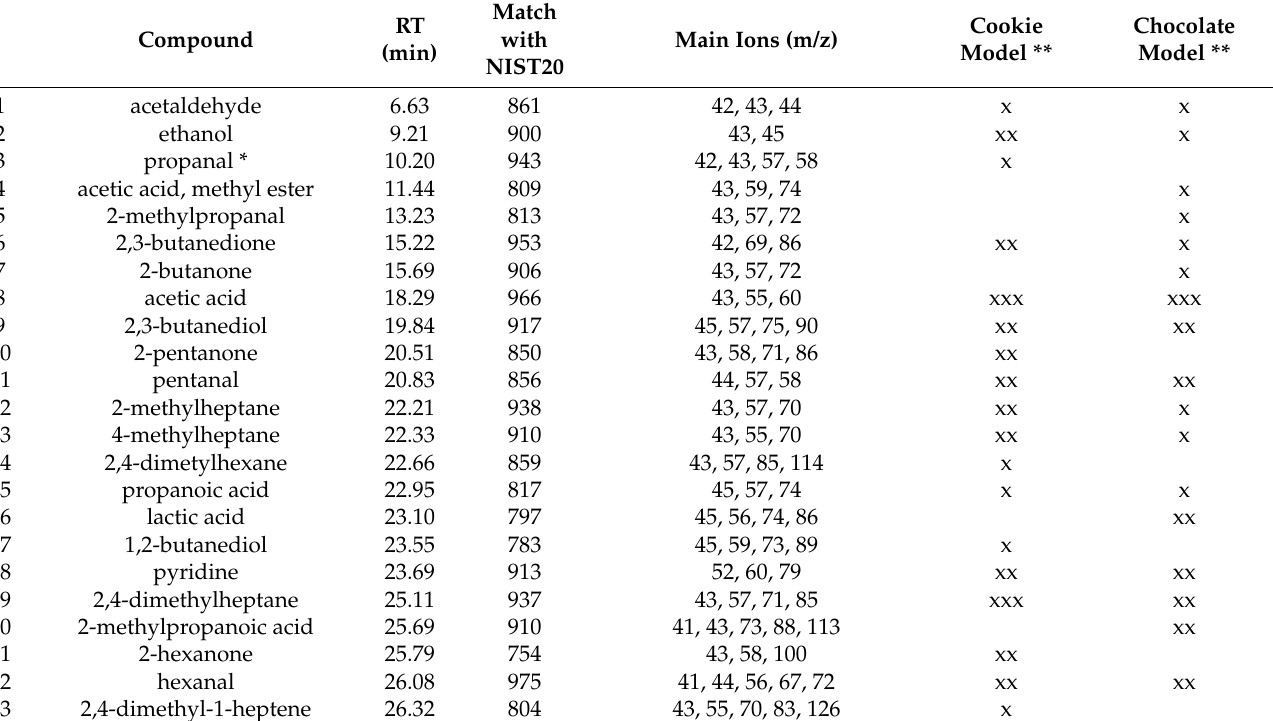
Table 3. Retention times, match with NIST library, and main ions in the mass spectra of 53 identified volatile compounds analyzed by headspace solid-phase microextraction with gas chromatography with mass spectrometer detection from non-stored shortbread cookie and dark chocolate models fortified with fish